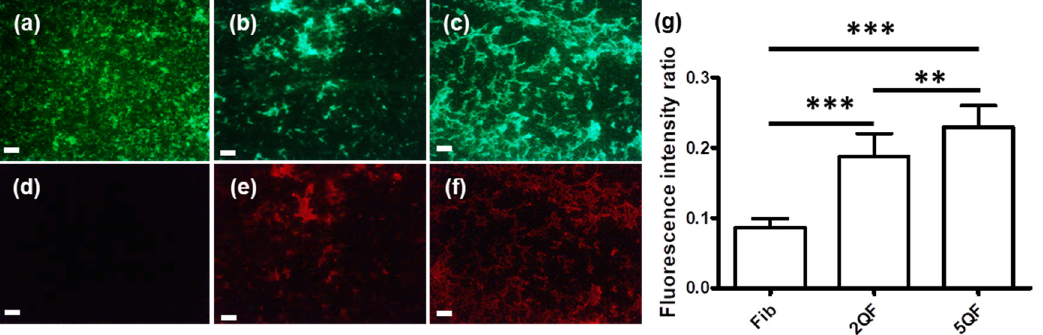
Figure 2. Fluorescence images of fibrils ( a , d ) Fib, ( b , e ) 2QF, and ( c , f ) 5QF shown by ThT ( a – c ) and 8H4 ( d – f ) staining. The scale bar represents 100 µm. ( g ) Quantitation of the fluorescence intensity ratio of 8H4/ThT. The statistical significance is represented by asterisk (**, p < 0.01; ***, p < 0.001).